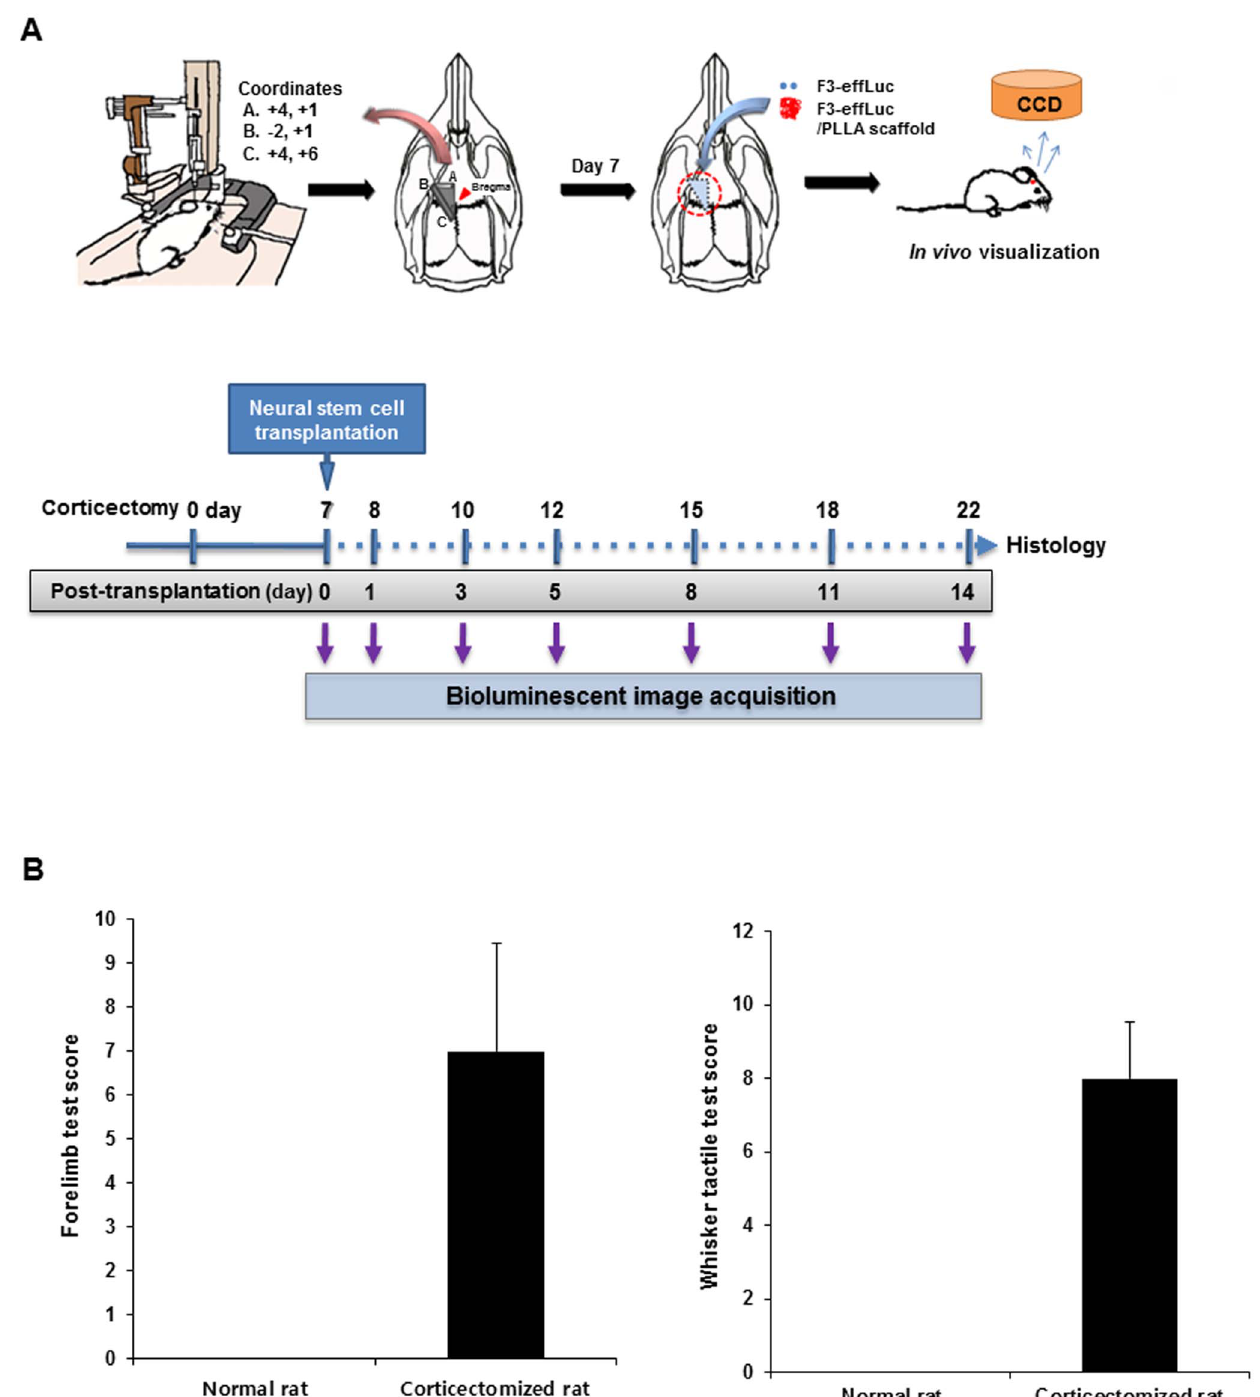
Figure 4. Schematic representation of the procedure for invivo optical imaging. (A) The protocol is for in vivo monitoring of F3-effLuc cells implanted in a corticectomized rat model. The motor cortex region of the Sprague-Dawley rat brain was surgically removed at the given coordinates and after 7 days, the rats were transplanted with F3-effLuc cells alone or F3-effLuc/PLLA scaffold complexes, and then administered cyclosporine A everyday. The grafted cells were monitored at 0, 1, 3, 5, 8, 11, and 14 days using a bioluminescence-imaging device. At the end of the implant period, histological analyses were performed using hematoxylin and eosin (H&E) staining and immunohistochemistry. (B) Behavior tests were performed 7 days after motor cortex ablation. The traumatic brain injury (TBI) models were evaluated by forelimb placing tests and whisker tactile tests in normal and corticectomized rats (n=10).